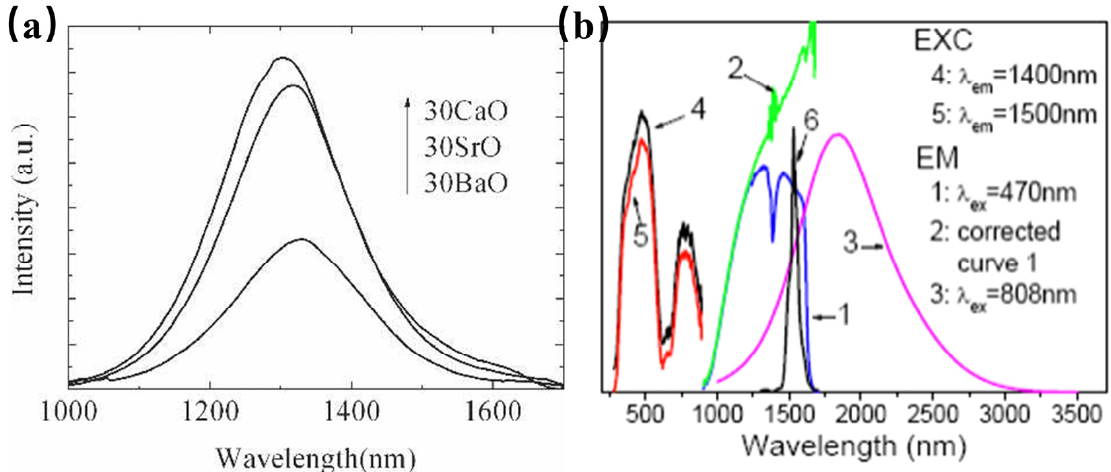
Figure 10. ( a ) Fluorescence spectra of glasses 65SiO 2 · 30RO · 5Al 2 O 3 . 1Bi 2 O 3 (R = Ca, Sr, and Ba), excited by 808 nm laser diode (Em = 1325 nm). ( b ) Emission and excitation spectra of Bi 5 (GaCl 4 ) 3 at room temperature.